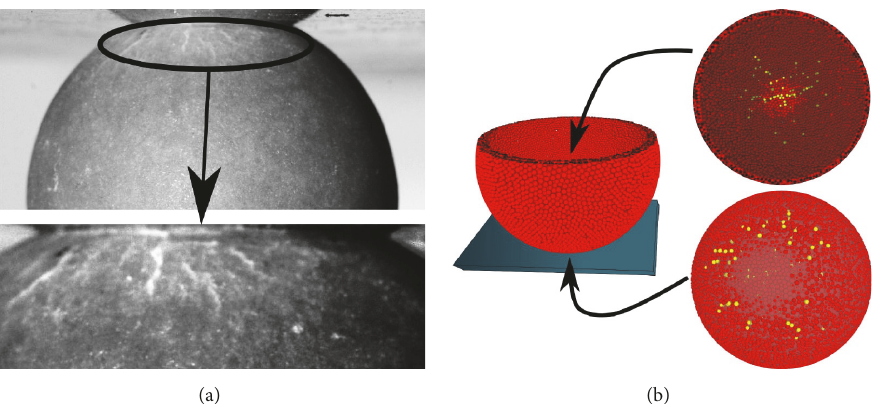
Figure 13: Zoom in the microcracks before the main crack on experimental data (a) and on numerical results (b) where broken elements are in yellow.